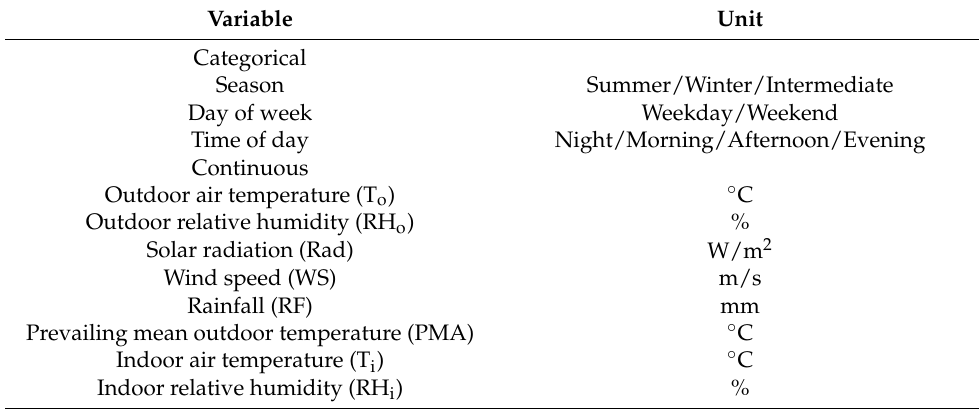
Table 2. List of explanatory variables.